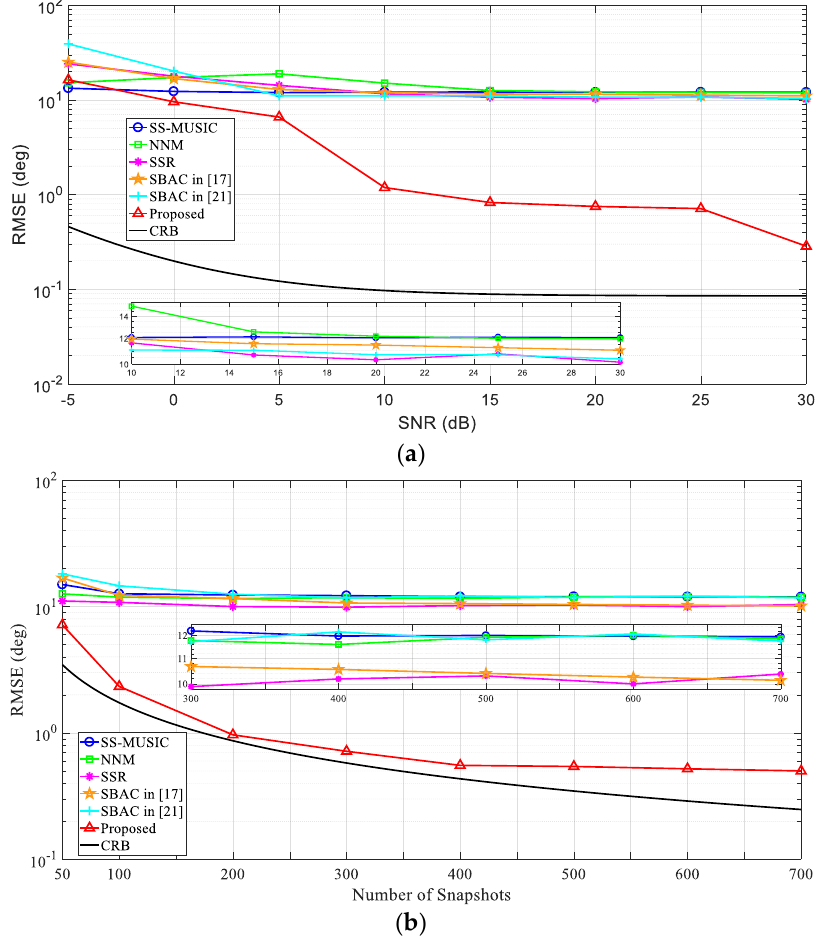
Figure 4. RMSE performance comparison with 11 incident sources. ( a ) RMSE versus SNR with the number of snapshots T = 2000; ( b ) RMSE versus the number of snapshots with SNR = 30 dB.